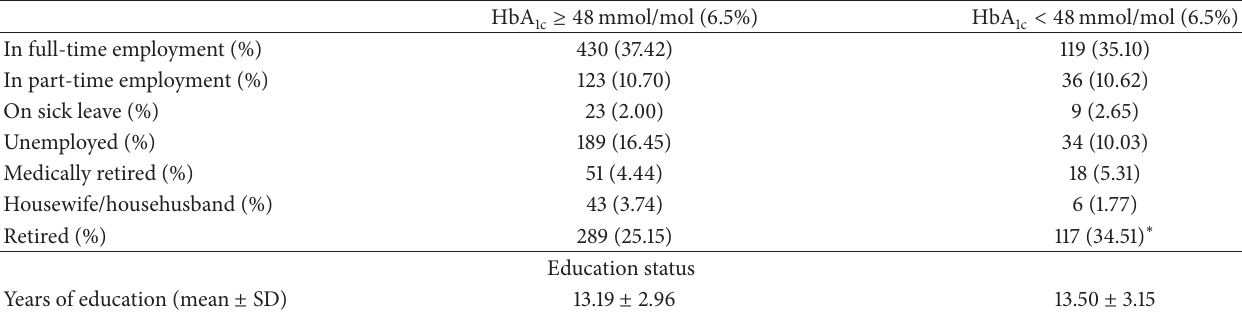
Table 2: Employment and educational